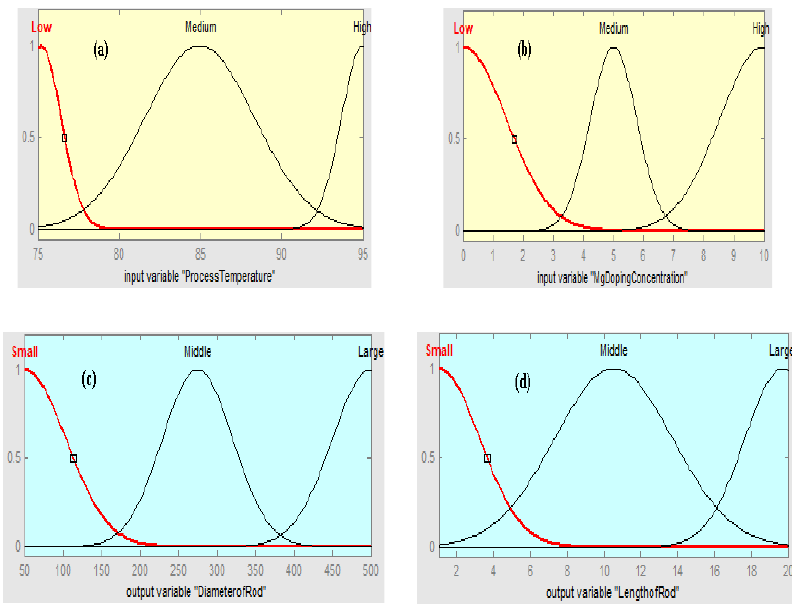
Fig. 3. Membership Function of Input and Output along with its Ranges (a) Process Tempera- ture (b) Mg Doping Concentration (c) Diameter of Rod (d) Length of Rod